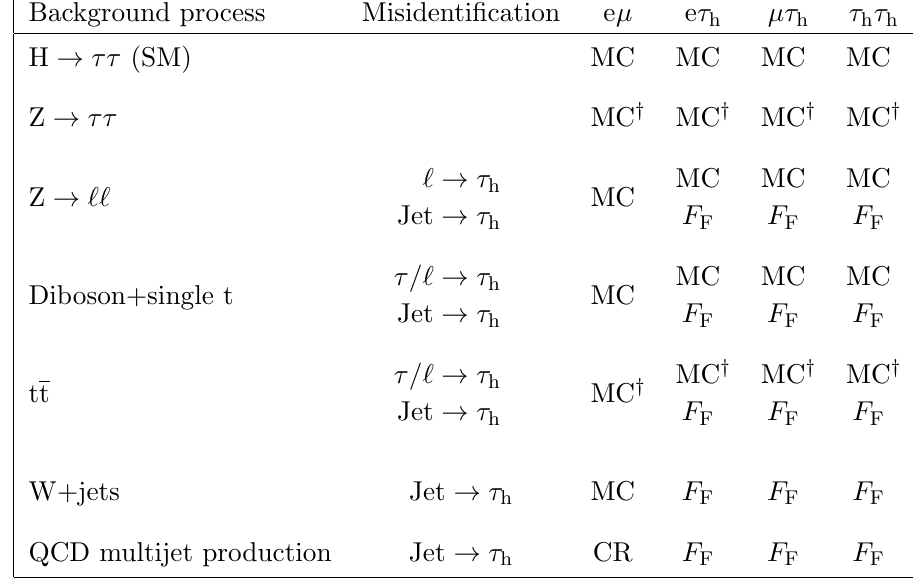
Table 2 . Background processes contributing to the event selection, as given in section 4. The (cid:12)rst row corresponds to the SM Higgs boson in the (cid:28)(cid:28) (cid:12)nal state, which is also taken into account in the statistical analysis. The further splitting of the processes in the second column refers only to (cid:12)nal states that contain a (cid:28) h candidate. The label \MC" implies that the process is taken from simulation; the label \ F F " implies that the process is determined from data using the fake factor method, as described in section 5.2. The label \CR" implies that both the shape and normalization of QCD multijet events are estimated from control regions in data. The symbol ‘ corresponds to an electron or